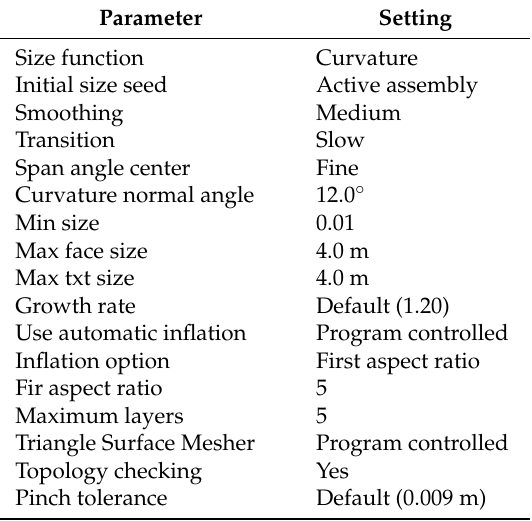
Table 1. Settings in ANSYS CFX for meshing the domain of interest.